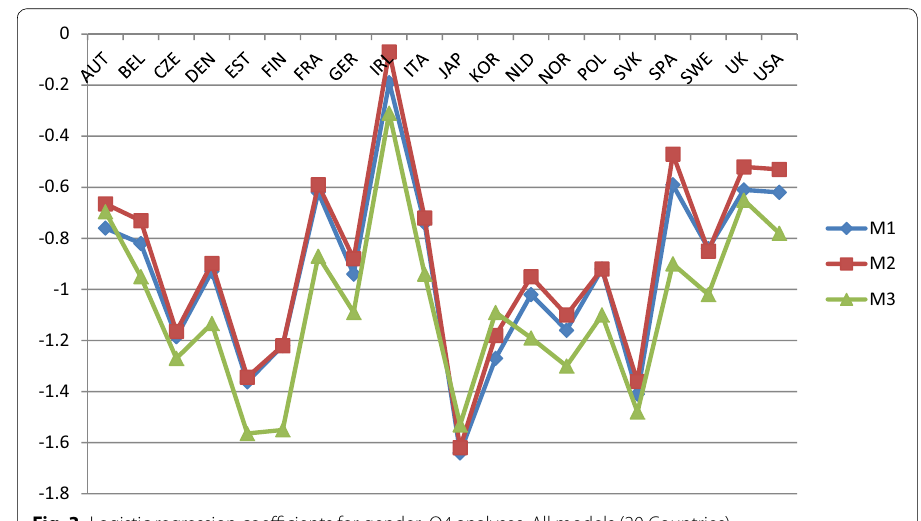
-1.8 Fig. 3 Logistic regression coefficients for gender: Q4 analyses, All models (20